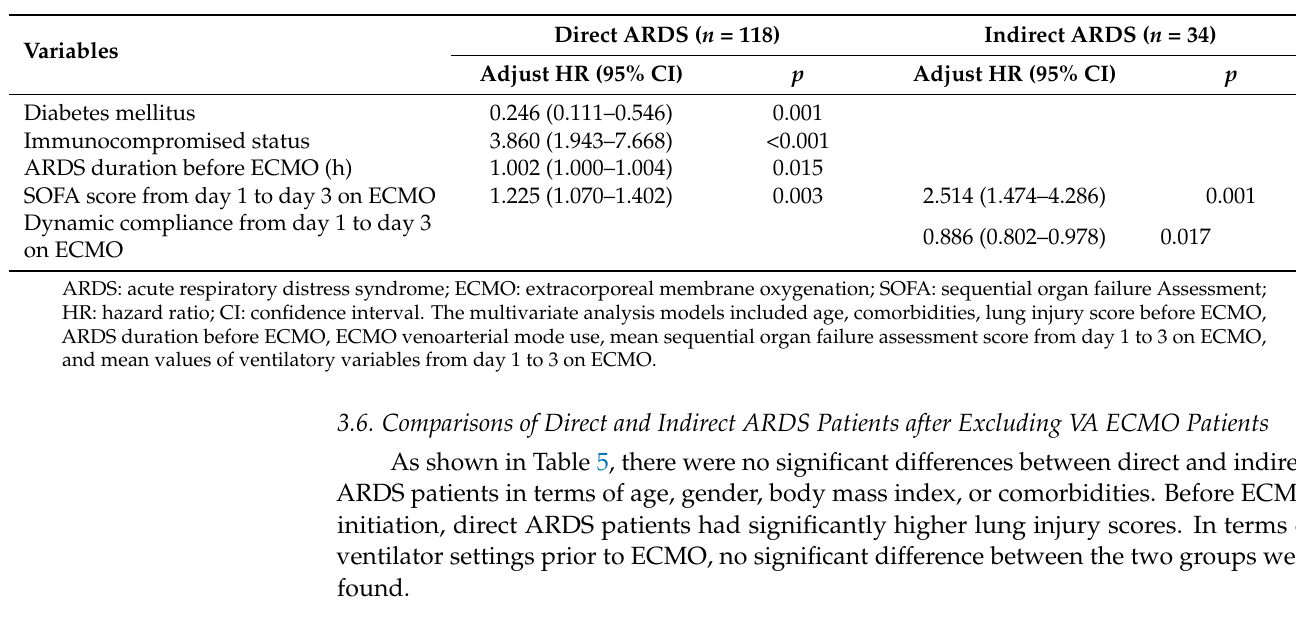
Table 4. Cox proportional hazard regression models for predictors of 90-day hospital mortality.